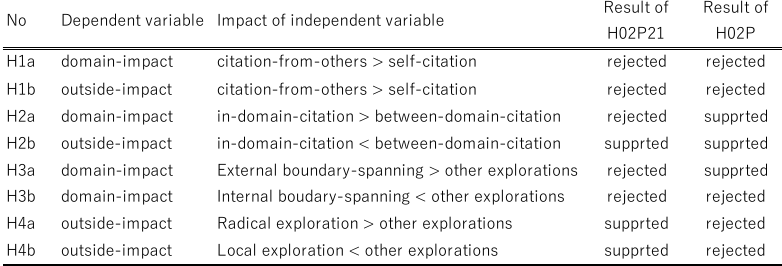
Table 8. Summary of the results No Dependent variable Impact of independent